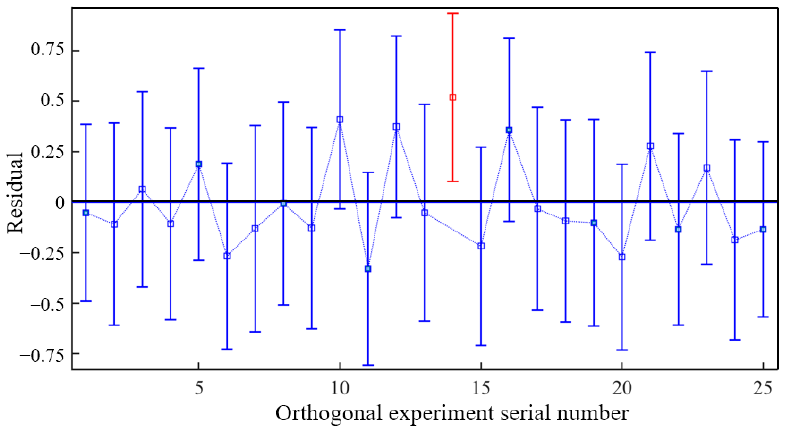
Figure 7. Residual diagram of the regression equation of the comprehensive safety factor of the mine wall.